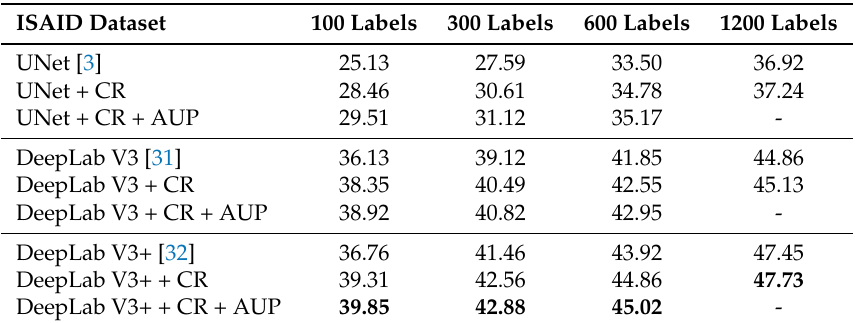
Table 4. Segmentation accuracy (mIoU, %) comparison of CR and AUP in our method on multi-class ISAID